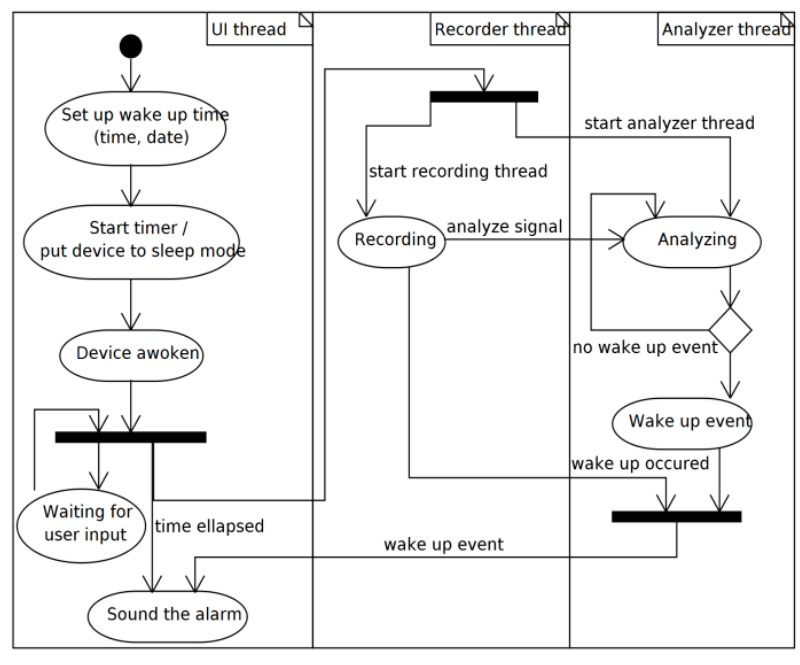
Figure 7. Application activity diagram.